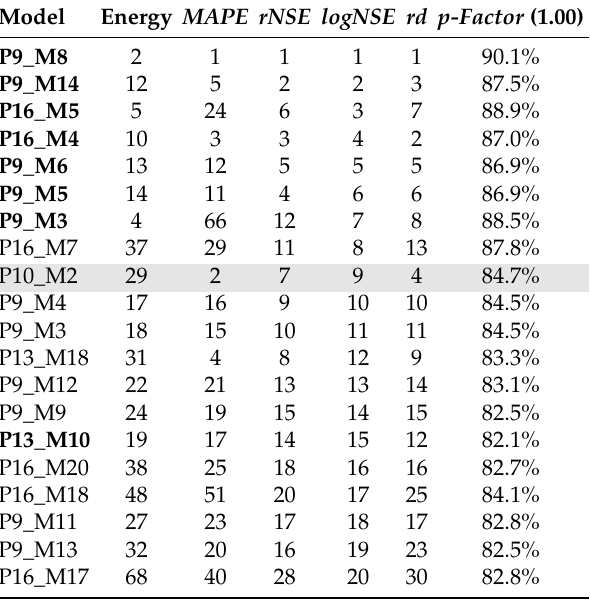
Table 12. (Real case) Ranking ascending by logNSE . The text in bold corresponds to the models with lowest energy consumption. The row shaded in gray corresponds to the best model selected by ZEC _ index